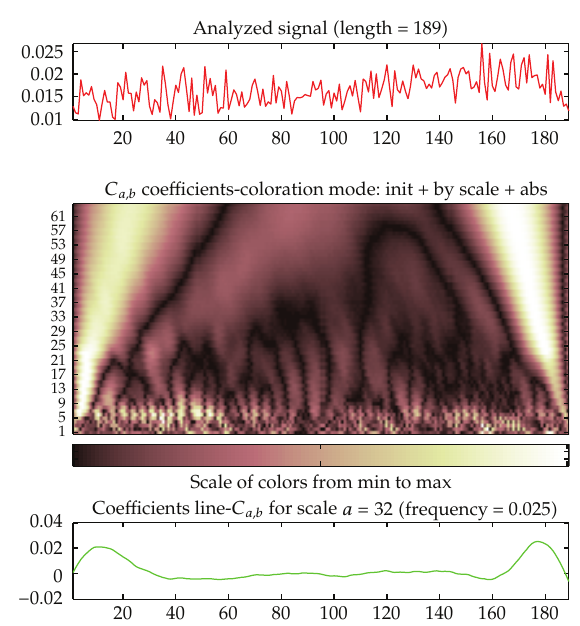
Figure 10: Daubechies continuous wavelet db3 filter of SCTfe/Spain INDEX.